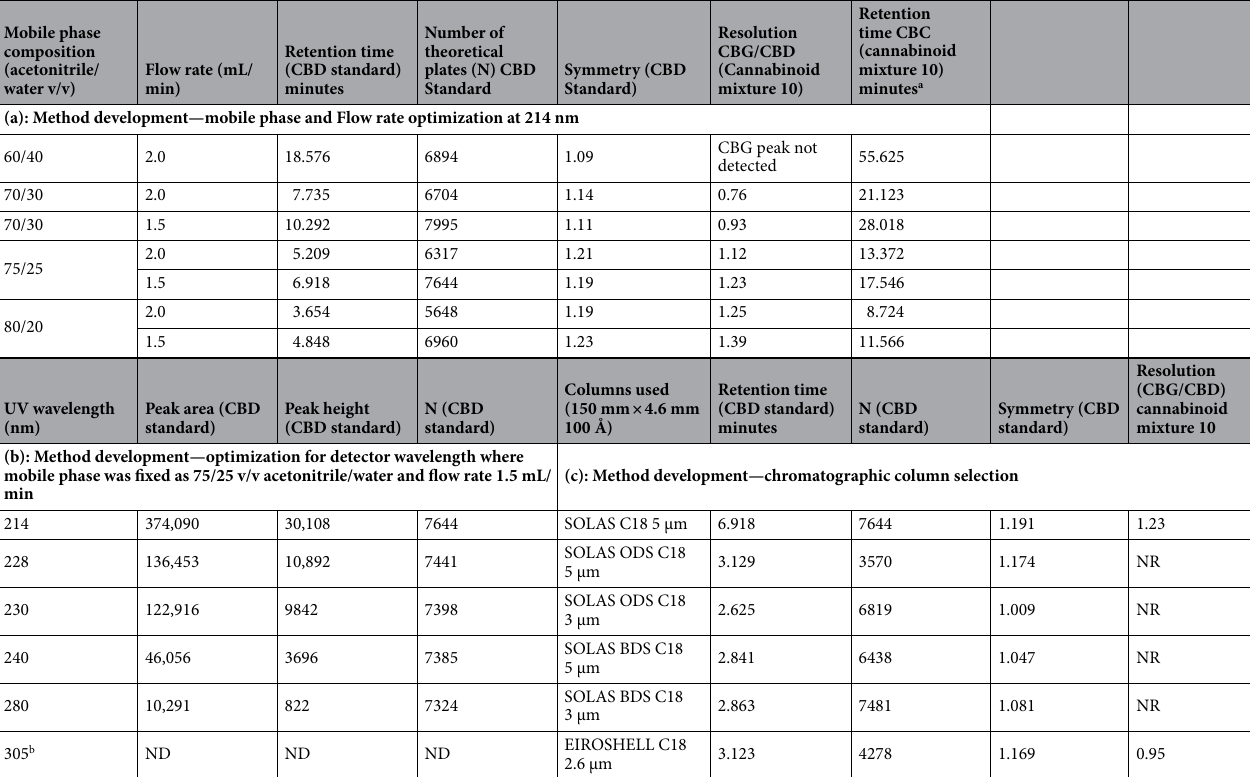
Table 1. Method development. ND Not detected, NR CBG not resolved from CBD. a CBC was eluted as the last peak in phytocannabinoid mixture 10 and was considered to choose the total run time for the samples. b 305 nm was used for identifying the cannabinoid peaks CBN and CBC.